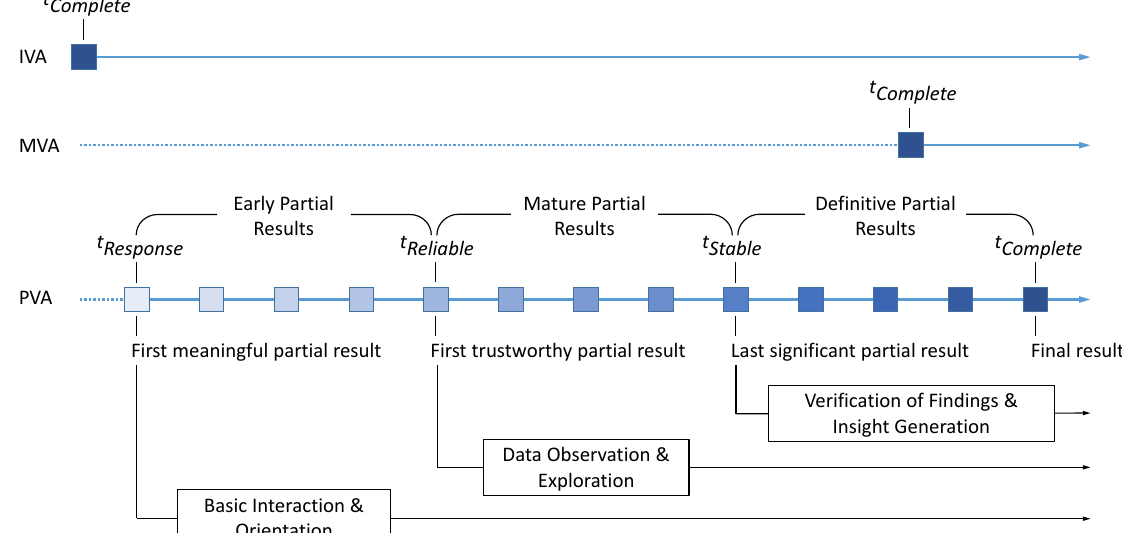
Figure 1. Instantaneous, Monolithic, and Progressive Visual Analytics described by their temporal characteristics. Dotted lines indicate wait times in which the analysis is stalled. Note that in the case of PVA, partial results of different quality can be used for different stages of visual analysis, roughly aligning with the different levels or loops of the knowledge generation model for visual analytics proposed by Sacha et al.,